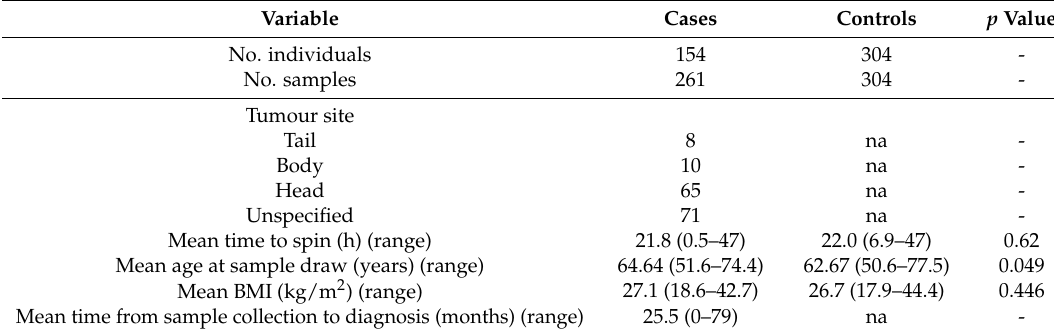
Table 4. Study set